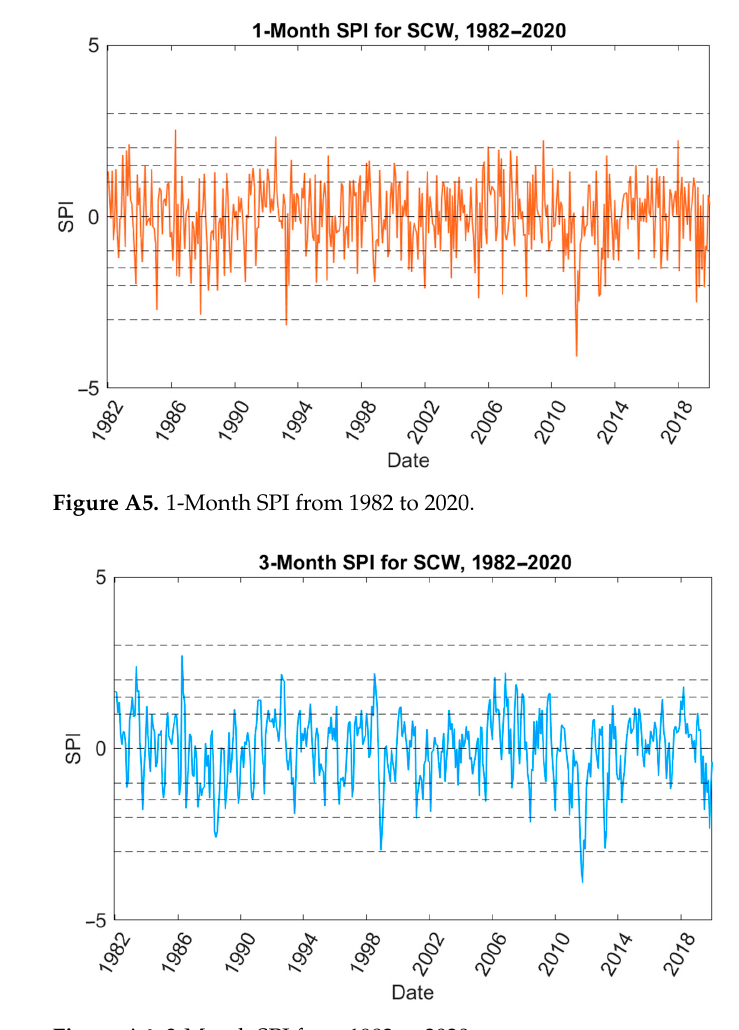
Figure A7. 6 ‐ Month SPI from 1982 to 2020.